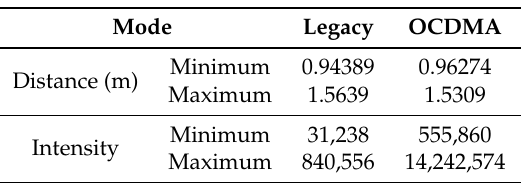
Table 5. Summary of the distance and the intensity measurements for the target watering can and the black matte paper